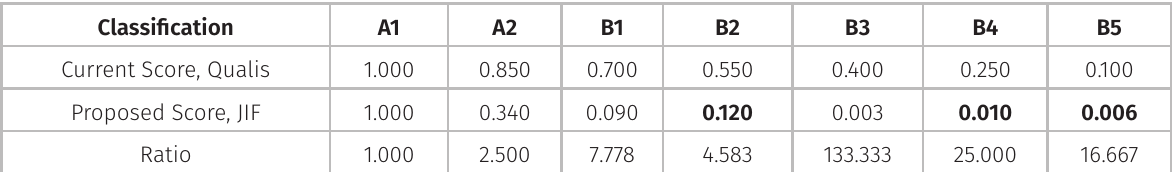
Table VII. Ratio between the Qualis score and JIF score for the sample. Classification Current Score,